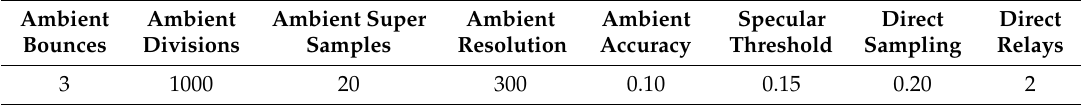
Table 4. Set of “r-trace”